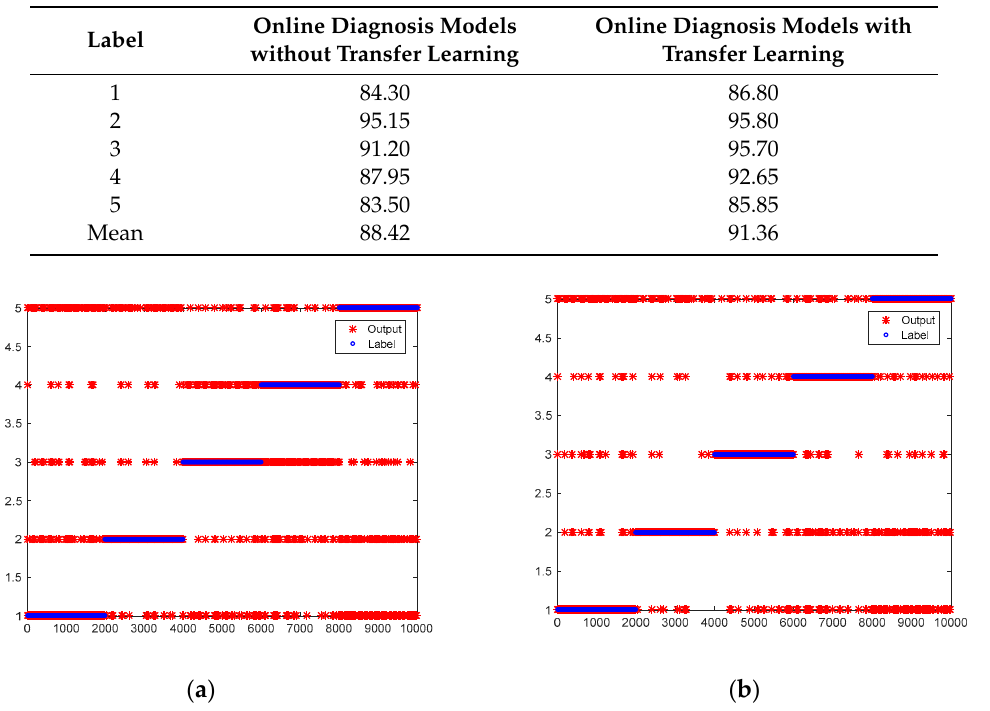
Figure 6. Test results of online diagnosis models without and with transfer learning. ( a ) Online diagnosis models without transfer learning; ( b ) Online diagnosis models with transfer learning.